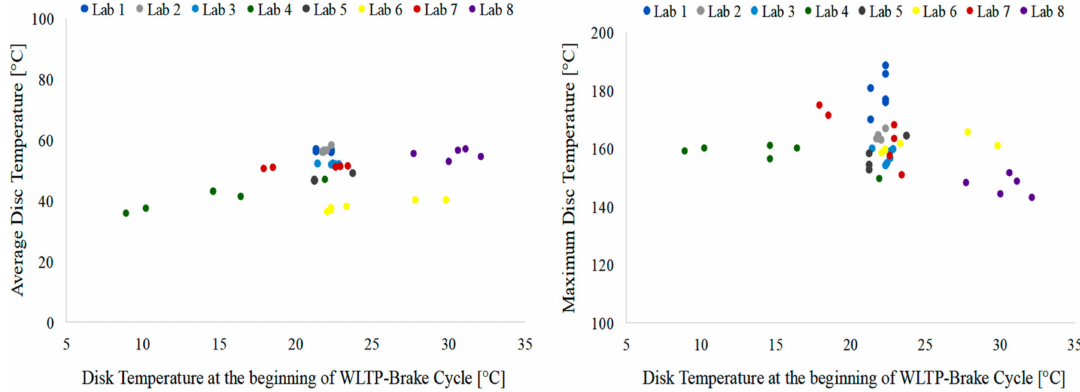
Figure 10. Average ( left-hand side ) and maximum ( right-hand side ) disc temperature over the WLTP–brake cycle plotted against the disc temperature at the beginning of the